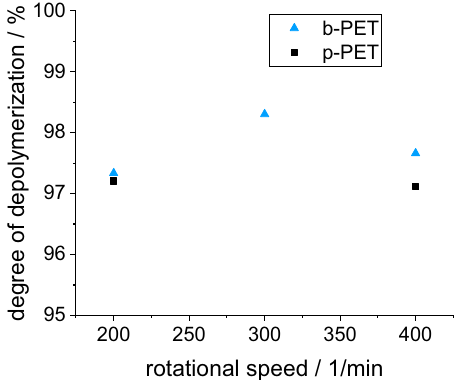
Figure 4: In fl uence of rotational speed on the degree of depoly - merization of b - PET and p - PET calculated according to Eq.